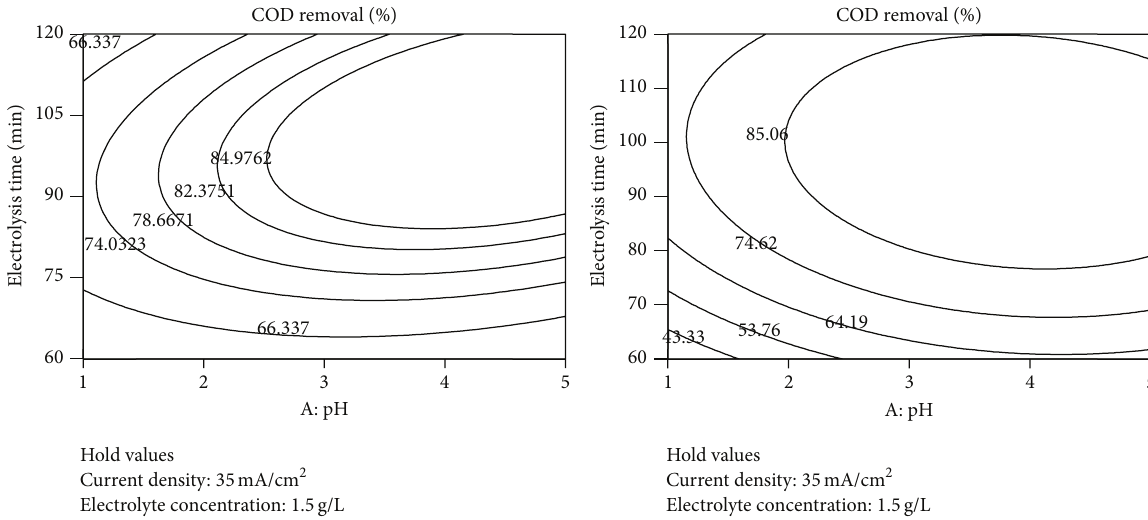
Figure 6: Contour plots between pH and electrolysis time for the